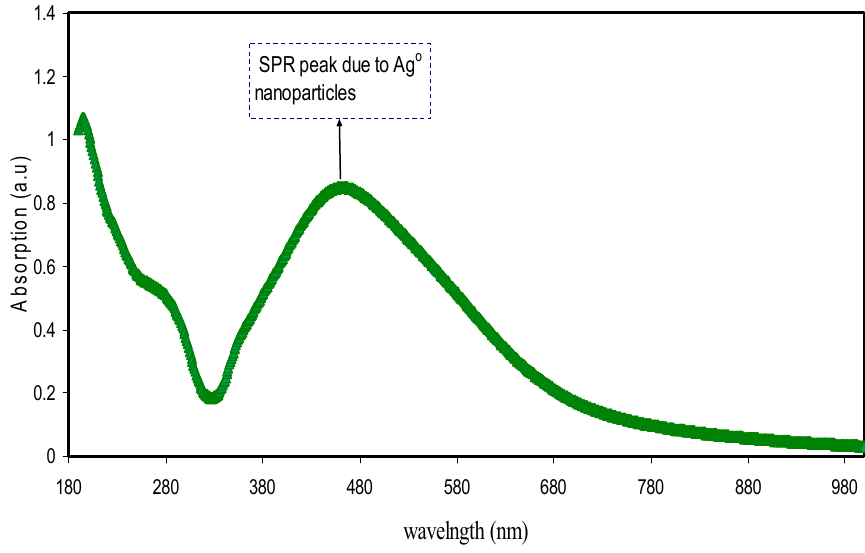
Figure 5. Absorption spectra for colloidal Ag nanoparticles.